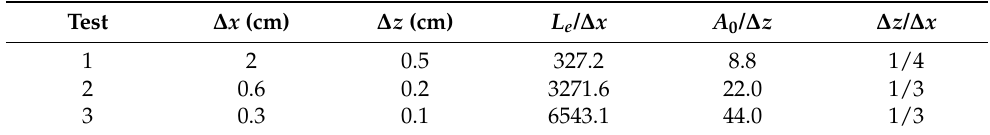
Table 2. Grid sizes used for resolution test.